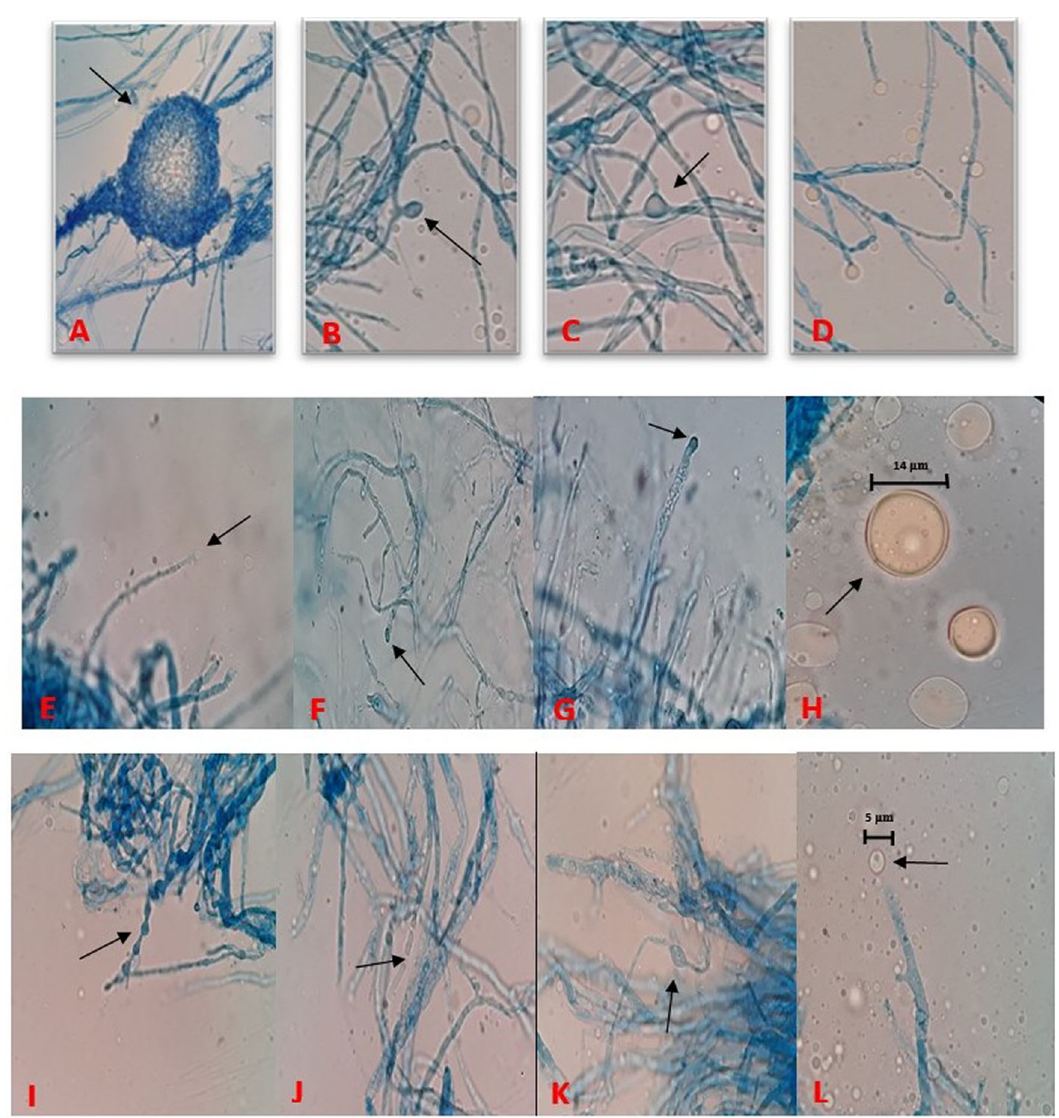
Figure 2. (A) Meiospore of MSU-101 isolate. (B) Immature sporangia from branched sporangiophore of MSU-101.(C)Intercalarychlamydospore ofMSU-101isolate.(D)Hyalineandovoidsporangia,MSU-201isolate. (E)Developingsporangiaonsinglesporangiophore,MSU-201isolate.(F)Immatureyoungsporangiaonhighly branched sporangiophore, MSU-201. (G) Immature young sporangia on highly branched sporangiophore, MSU-401. (H) Mature globose sporangium containing sporangiospores, MSU-401. (I) Terminal chlamydo- spores with papillate ornamentation and hyphal segment remaining at the distal end, MSU-501. (J) Net of hyphawithbranchingandseptation,MSU-501.(K)Netofhyphawithbranchingandchlamydospore,MSU-501. (L) Developing sporangium at tip on sporangiophore,